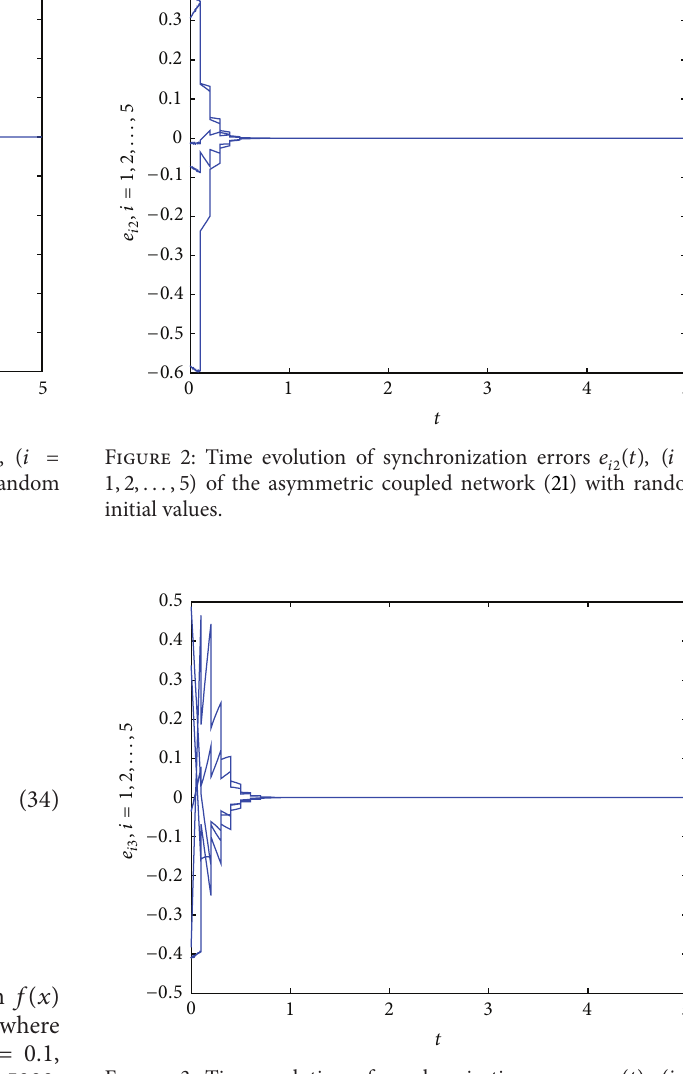
Figure 3: Time evolution of synchronization errors 𝑒 𝑖3 (𝑡), (𝑖 = 1, 2, .. ., 5) of the asymmetric coupled network (21) with random initial